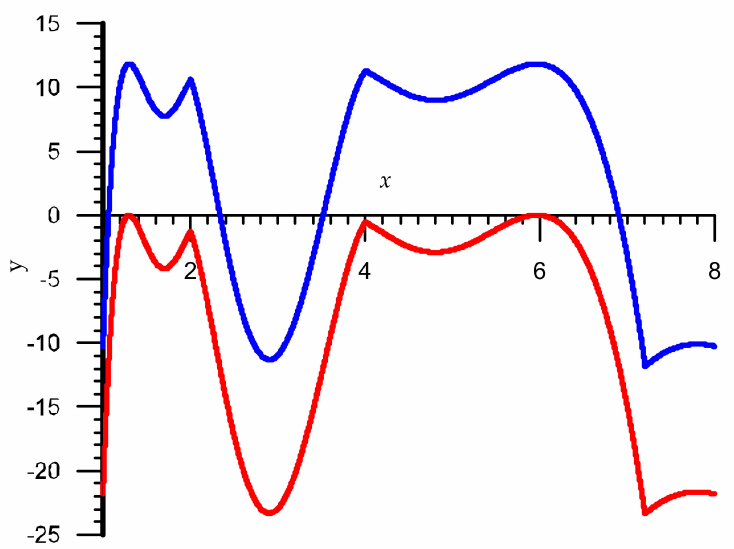
Figure 1. The first iteration relative error graphs for the interval x ∈ [1,8) (red color: Algorithm 1, blue color: Algorithm